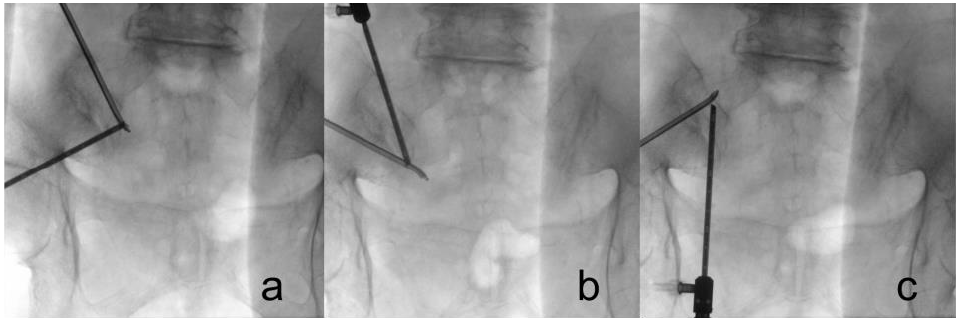
Figure 3. Fluoroscopes were used to guide the ablation point. ( a ) S1 foramen; ( b ) S2 foramen; ( c ) L5 dorsal ramus, which is located at the junction of the sacral alar and